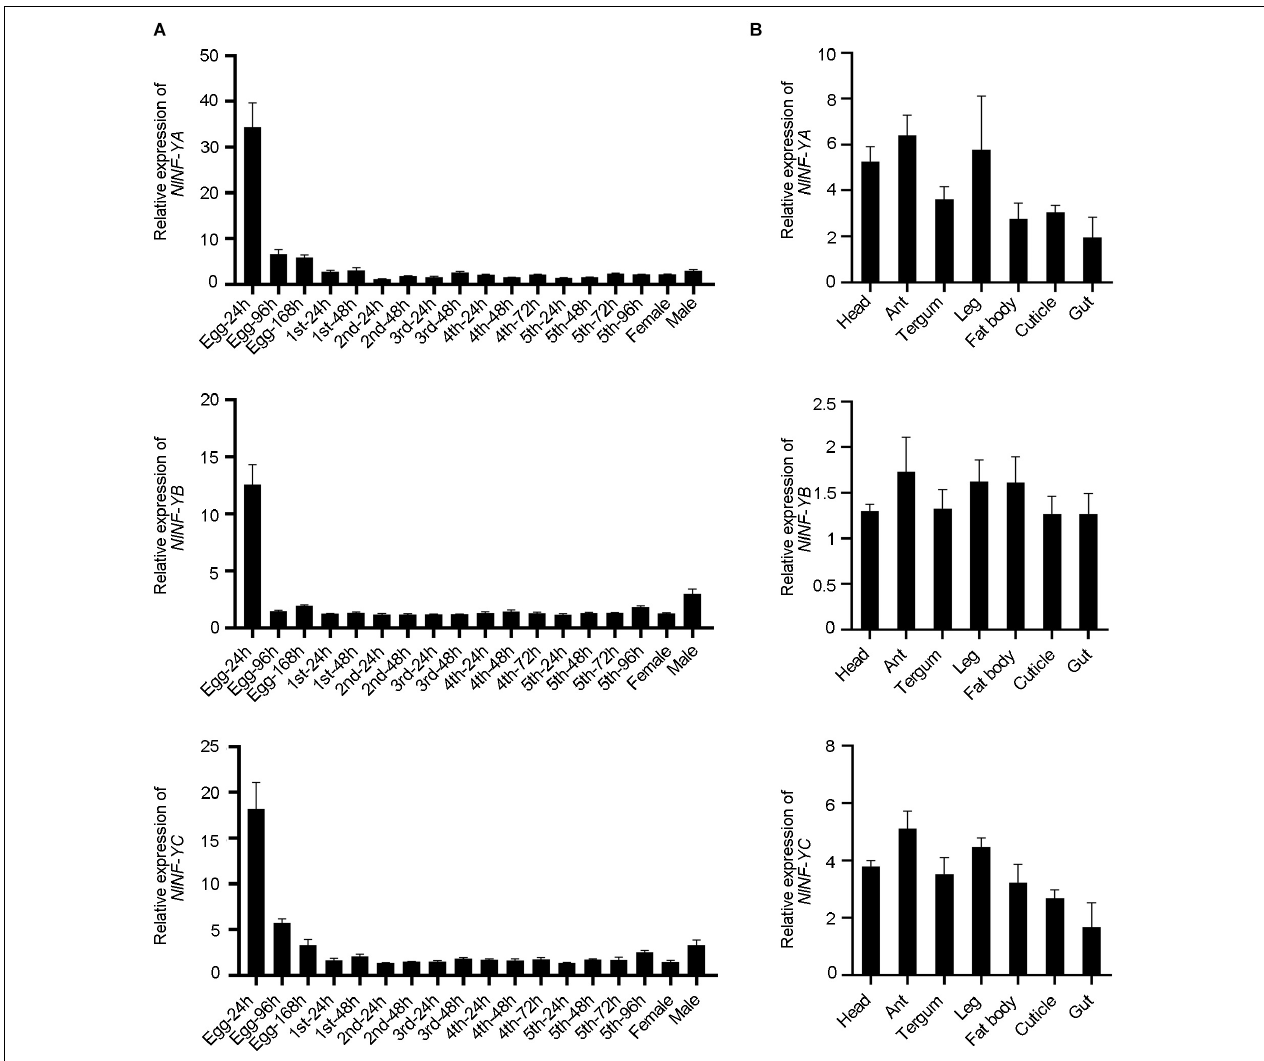
FIGURE 2 | Spatio-temporal expression of NlNF-Y genes. (A) Developmental profile of NlNF-YA , NlNF-YB , and NlNF-YC . Total RNAs were isolated from eggs ( n = 100), first-instar ( n = 100), second-instar ( n = 50), third-instar ( n = 50), fourth-instar ( n = 30), fifth-instar nymphs ( n = 15), and adult females ( n = 15). (B) Tissue distribution of Nl NF-Y. Total RNAs were extracted from the head ( n = 30), antenna (ant, n = 200), tergum ( n = 50), leg ( n = 100), fat body ( n = 30), cuticle ( n = 50), and gut ( n = 100) from fourth-instar nymphs. First-strand cDNA was synthesized using random primers, and qPCR was conducted using specific primers corresponding to each gene. The relative expression level was normalized by the ribosomal S11 gene ( rps11 ). Bars represent s.d. derived from three independent biological replicates.